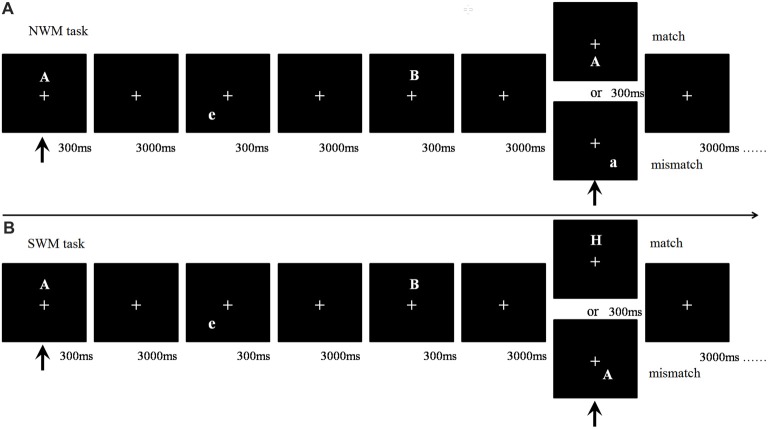
Flow chart of working memory (WM) task types. (A) Nonspatial working memory (NWM) task. The first arrow indicates the appearance of the first (target) stimulus and the beginning of the task. The second arrow indicates the appearance of the fourth (probe) stimulus, where participants were required to match the fourth and first stimuli. A match trial occurred if the 4th and 1st letters matched (case sensitive), otherwise it was a mismatch trial. (B) Spatial working memory (SWM) task. Participants needed to match the location of a letter between the 4th and 1st trials. A match trial occurred if the 4th and 1st letters had matching locations otherwise it was a mismatch trial.